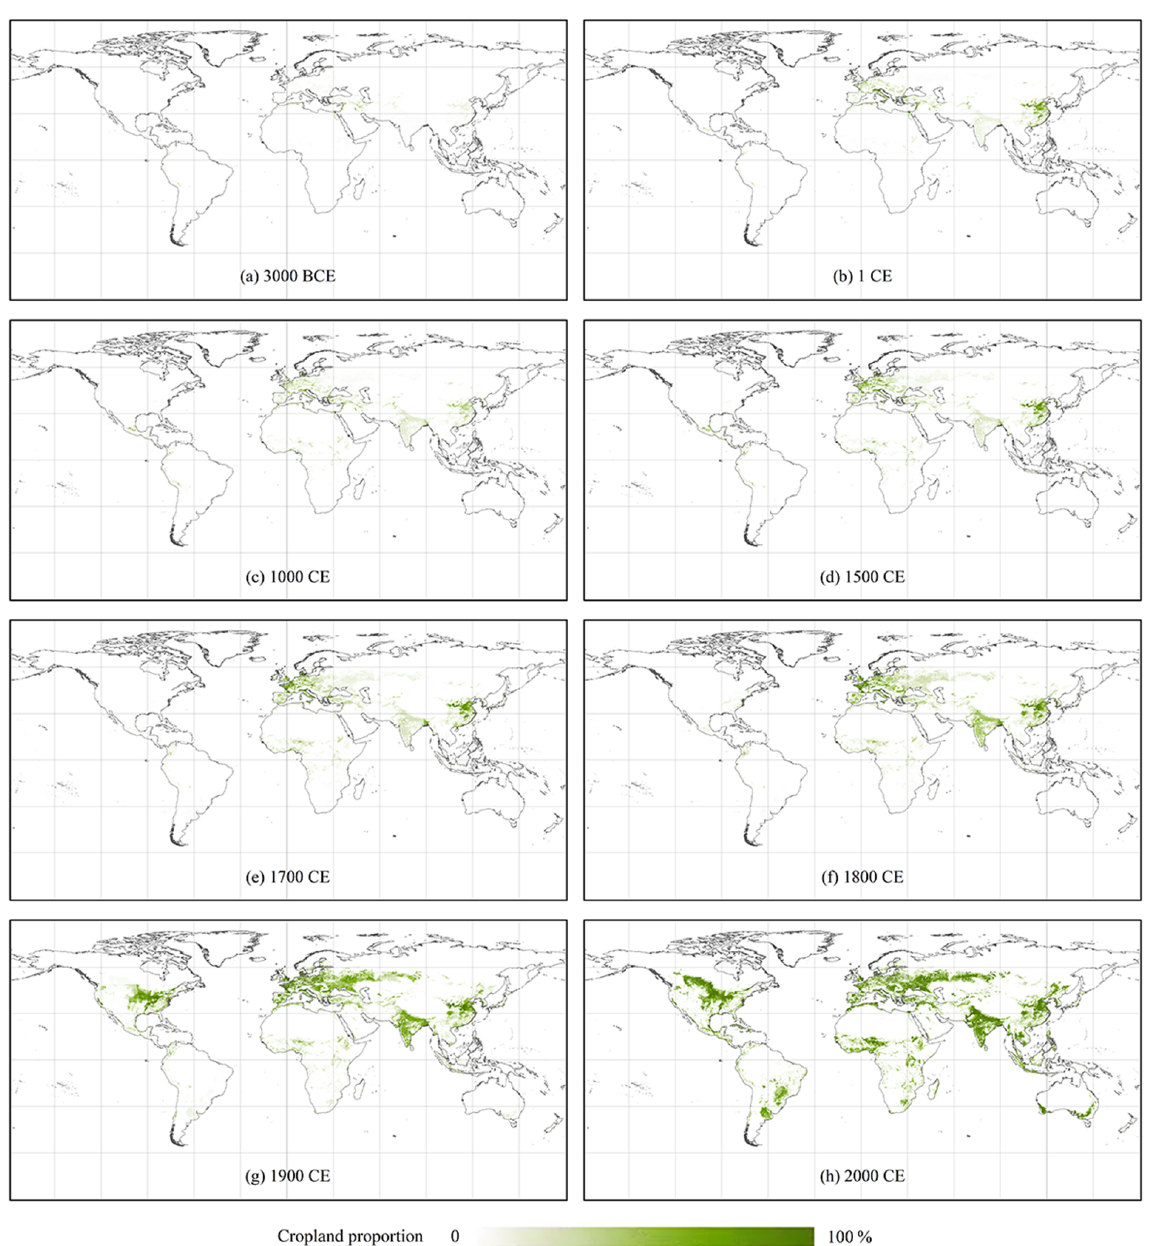
Figure 2. Downscaled historical cropland maps in (a) 3000BCE, (b) 1CE, (c) 1000CE, (d) 1500CE, (e) 1700CE, (f) 1800CE, (g) 1900CE, and (h)